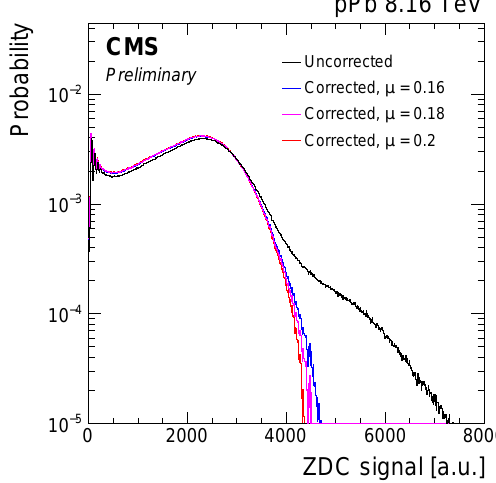
Figure 6. Pileup correction results with Fourier deconvolution method with different µ values assumed ( left ) and the percentiles of the ZDC signal distribution, used for centrality determination ( right )